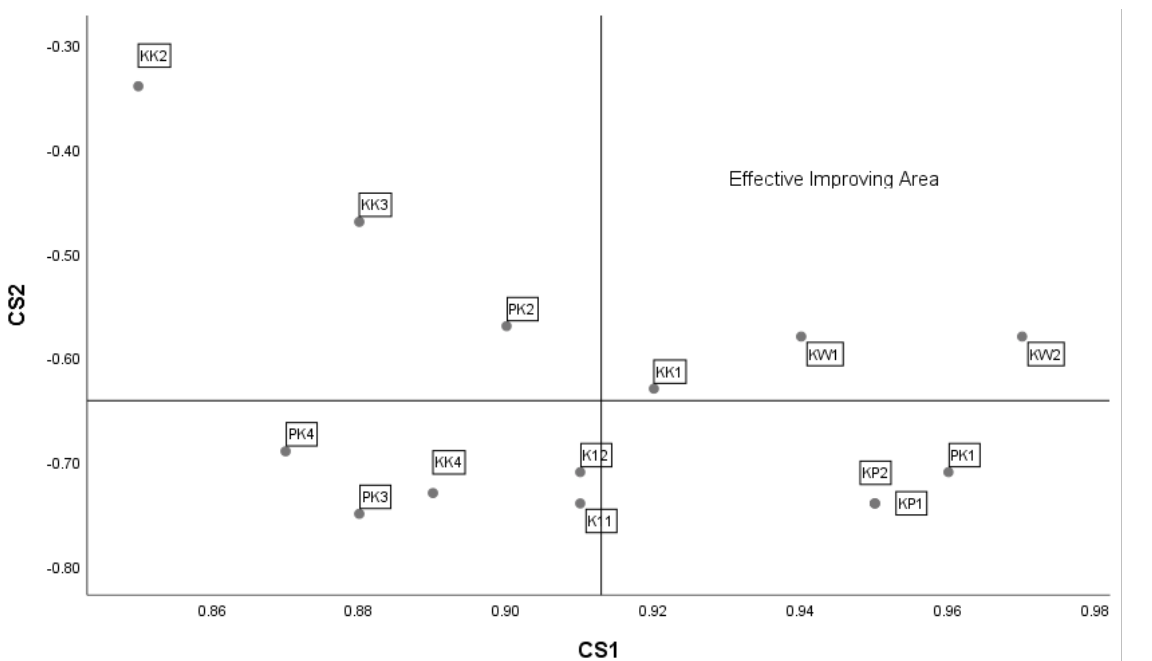
Figure 1. The map of cs coefficients on logistics service attributes.